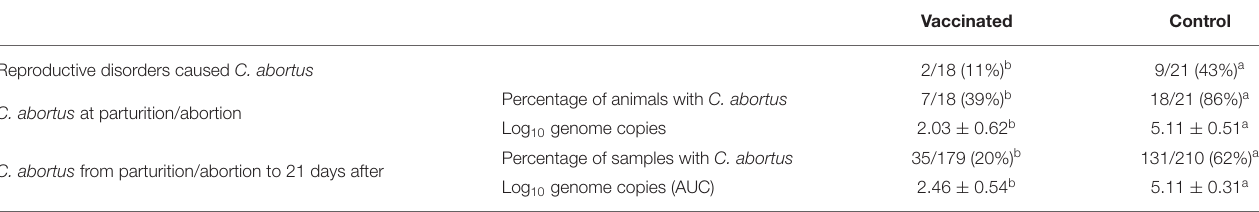
TABLE 3 | Presence of reproductive disorders caused by C. abortus , the percentage of vaginal swab samples with presence of C. abortus and the average titration of C. abortus from vaginal swab samples (numbers of genome copies of C. abortus per sample) of pregnant ewes per group. Vaccinated Control Reproductive disorders caused C. abortus 2/18 (11%) b 9/21 (43%) a Percentage of animals with C. abortus C. abortus at parturition/abortion Percentage of samples with C.